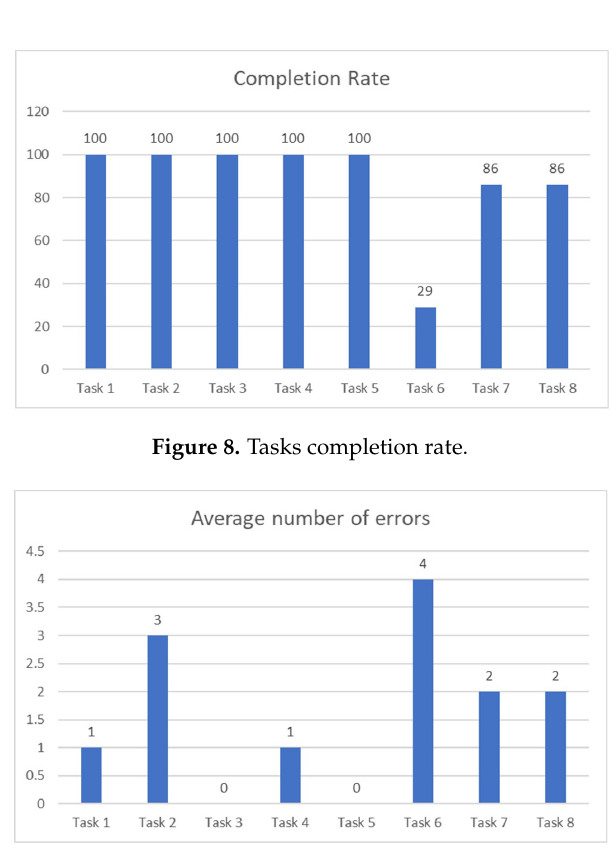
Figure 9. Average number of errors per task.